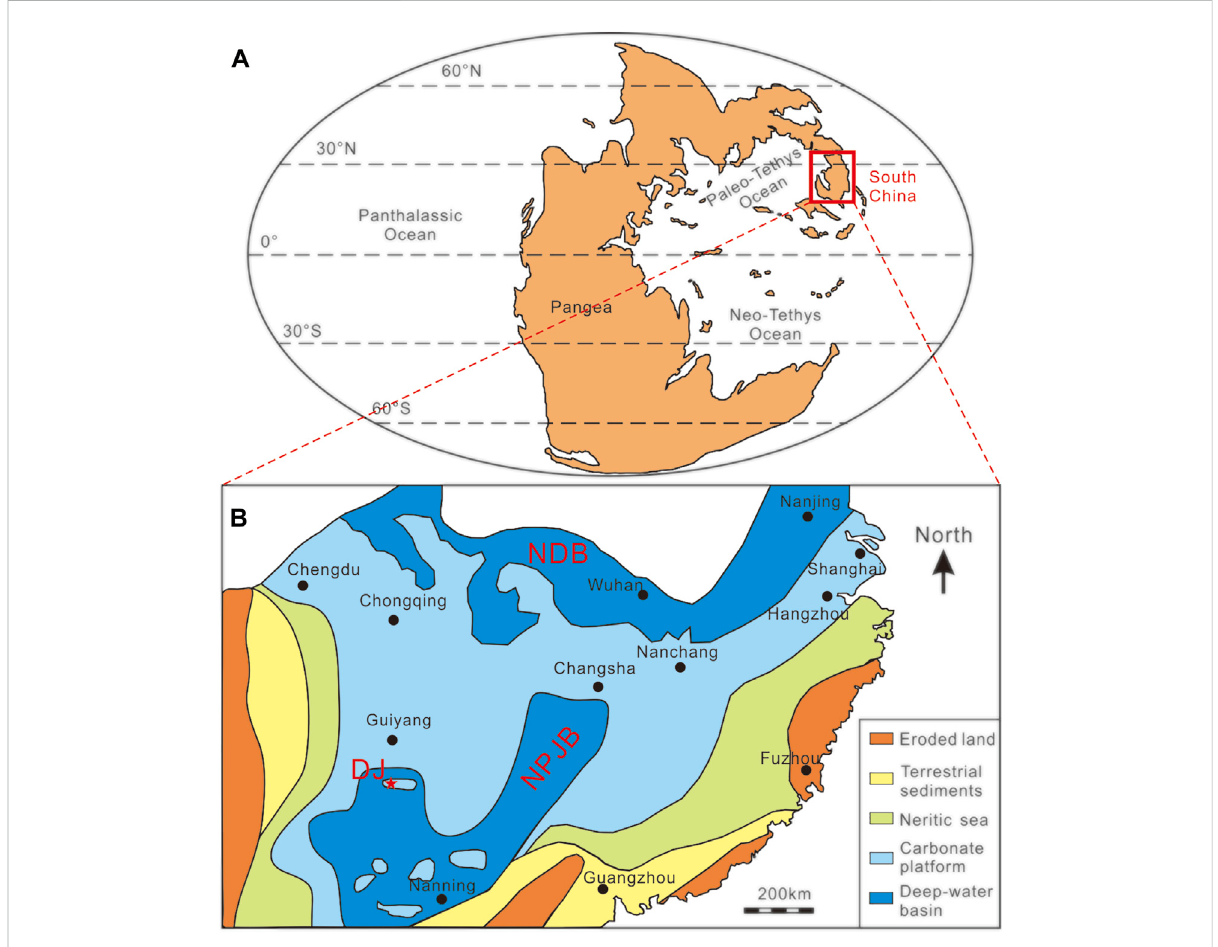
Permian-Triassic paleogeographic sketch map of the world (A) and the South China Craton (B) . Inset red rectangle in (A) shows the area of the South China Craton. The red star in (B) shows thelocation ofthe Dajiang section. Paleogeography ofthe world is revised from Shen etal. (2015), and themapoftheSouthChinaCratonismodi fi edfromXieetal.(2010)andYinetal.(2014).DJ:Dajiangsection;NDB:NorthernDeepwaterBasin;NPJB: Nanpanjiang